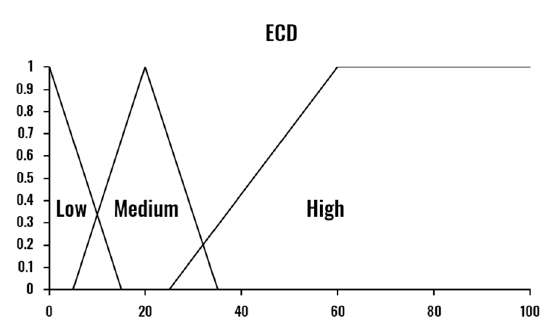
Figure 3. Fuzzy membership functions for PERCLOS.